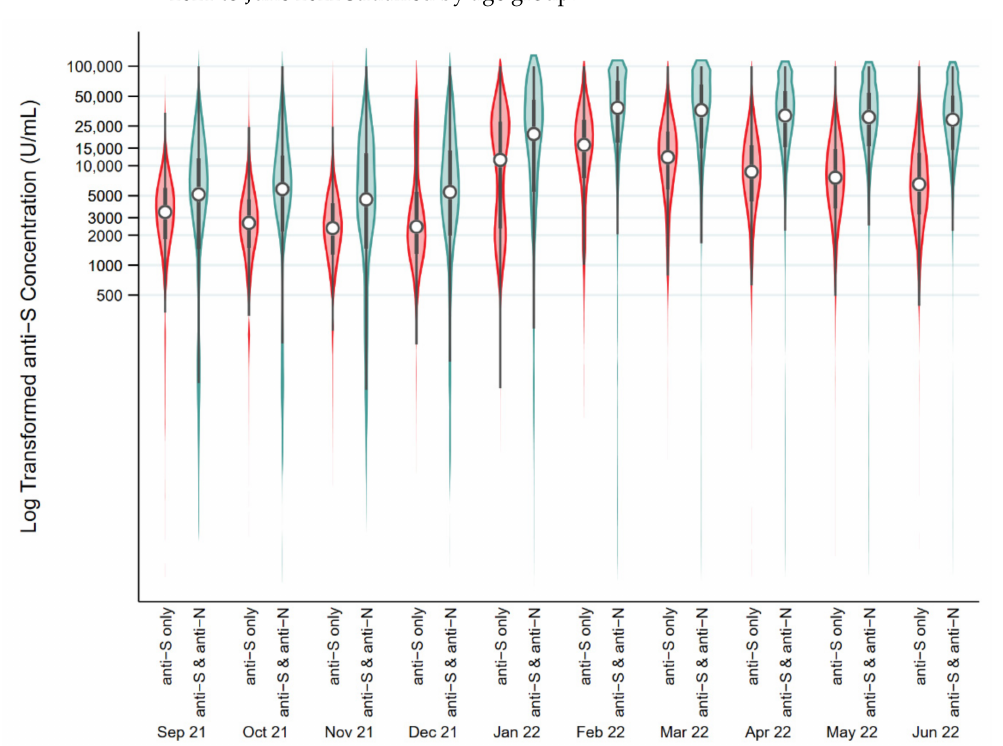
Figure 4. Distributions of log transformed Spike antibody concentration results (U/mL) (circle represents the median and the bar represents the interquartile range) in donations from September 2021 to June 2022 stratified by donors who were anti-S positive only or those who both were anti-S and anti-N